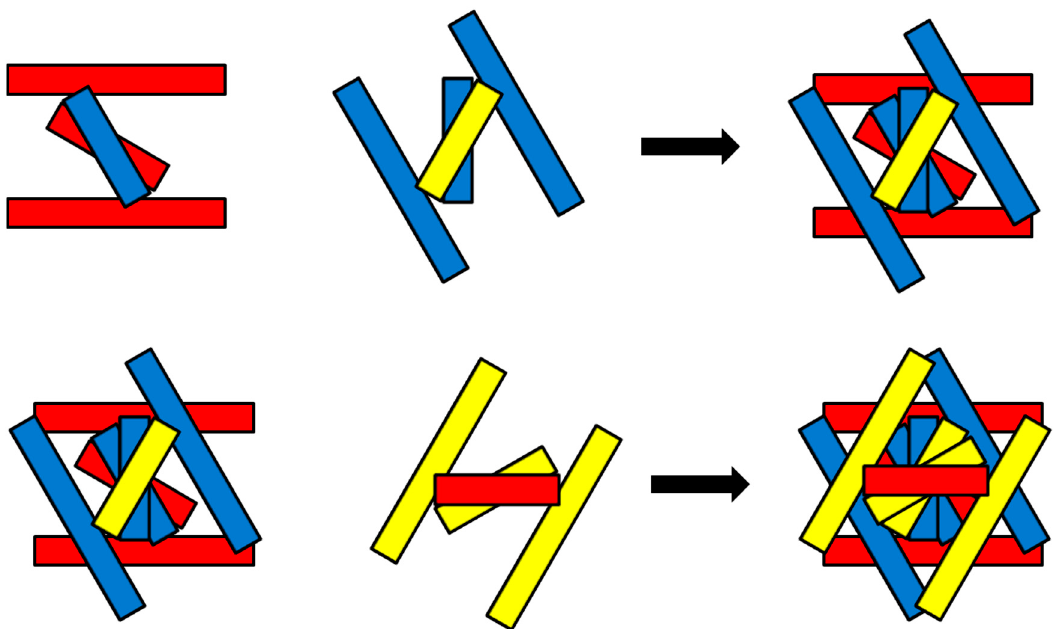
Figure 5. Schematic view of packing of spiral [[M(NCS) 2 (bpa) 2 ] · biphenyl] n (M = Fe, Co). The long stick shows M(NCS) 2 (bpa) 2 (M = Fe, Co) chain, while the short stick shows biphenyl. Elements with the same color have the same height.